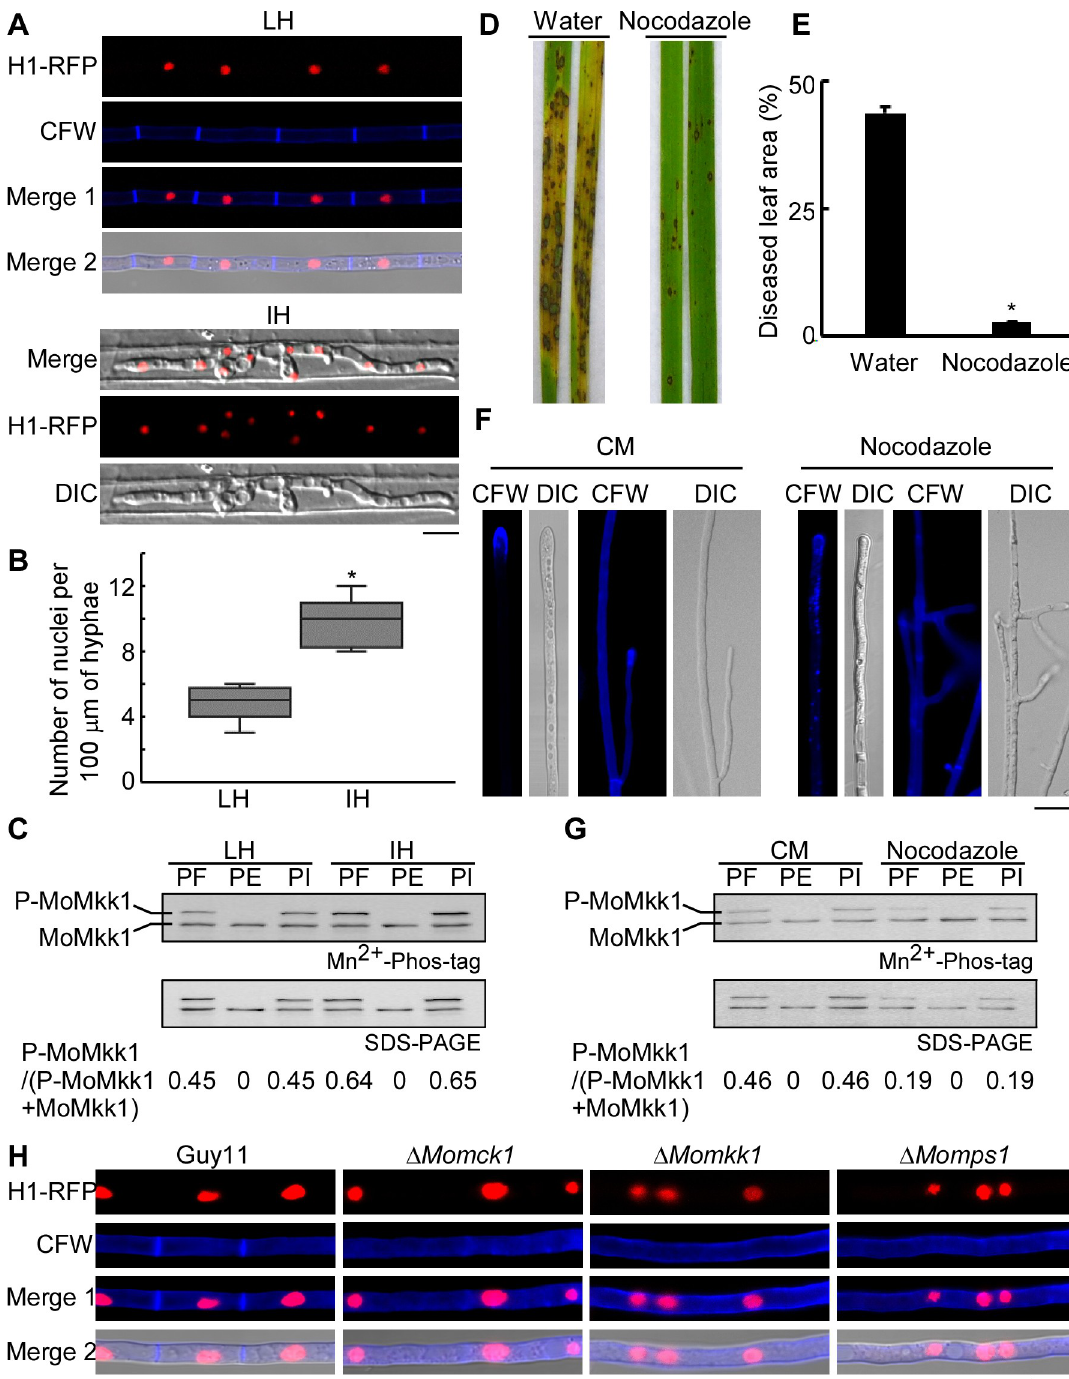
Fig 1. The balance of mitosis and cell wall integrity (CWI) is vital for vegetative and infectious growth of M . oryzae . (A) Liquid cultured hyphae (LH) and infectious hyphae (IH) of the Guy11 transformant expressing H1-RFP were examined by epifluorescence microscopy. Bar, 10 μ m. (B) Statistical analysis of the number of nuclei per 100 μ m of hyphae of (A). One hundred hyphae were counted for each type and the experiment was repeated three times. Error bars represent the standard deviations. Asterisks indicate statistical significance according to a Student’s test (p < 0.01). (C) Phosphorylation analysis of MoMkk1 in LH and IH. MoMkk1-GFP proteins were extracted in the presence of PMSF (PF), phosphatase (PE), as well as phosphatase inhibitors (PI), respectively, and then detected by the anti-GFP antibody. MoMkk1 phosphorylation was estimated by calculating the amount of phosphorylated-MoMkk1 (P-MoMkk1) compared to the total amount of MoMkk1 (the numbers underneath the blot). (D) Pathogenicity test in rice. The spore